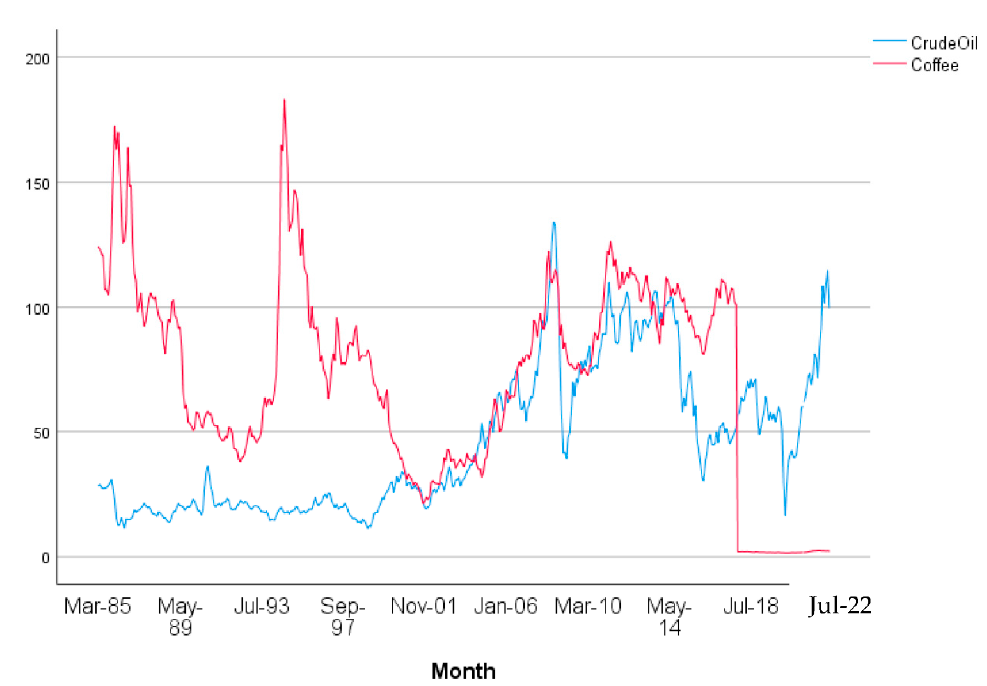
Figure 7. Time-Series Plot of Crude Oil and Coffee Price Patterns.